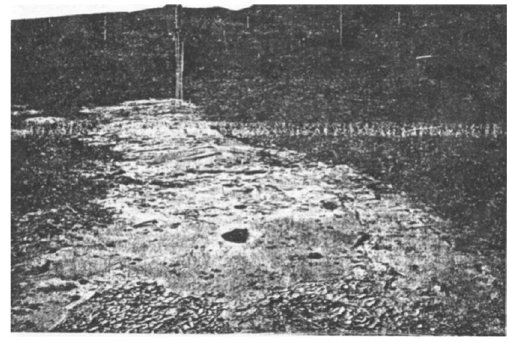
Fig. 2 Craters of liquefied soil on the banks of the Chlef river [21]